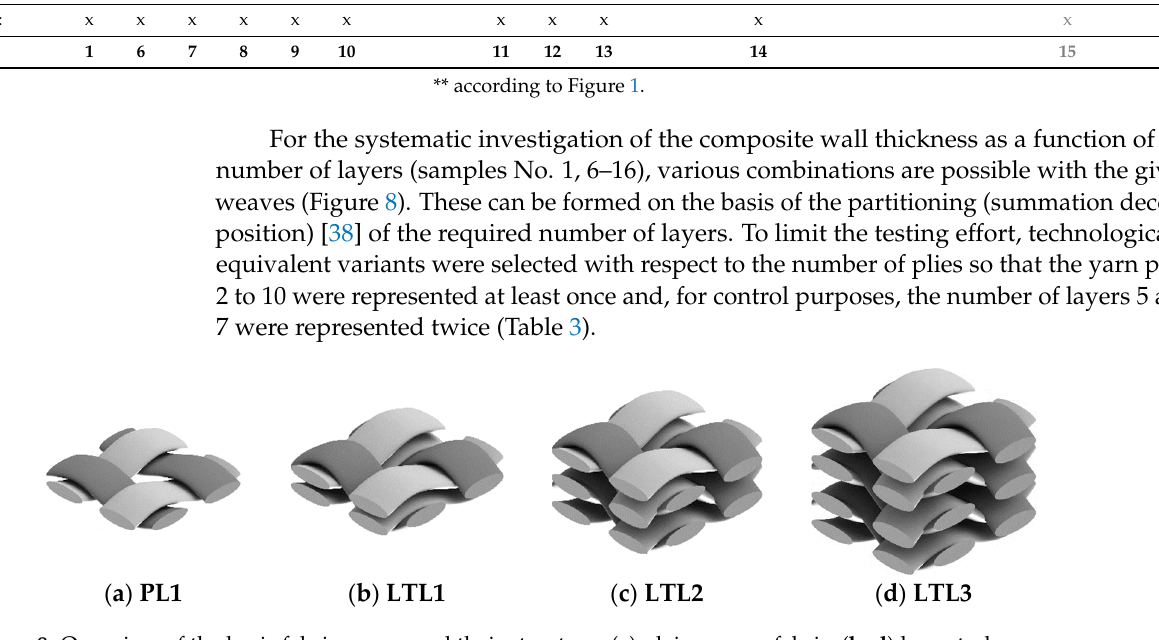
Figure 10. Temperature–pressure–time diagram of the sample consolidation. 4.2. Methods All measurements on textile and composite samples were carried out under standard climate conditions (DIN EN ISO 139: 20 °C, 65% rel. humidity) [39] and after a minimum of 48 h sample conditioning, in order to establish an equilibrium with regard to the water absorption of polyamide from the environment. The fabric thickness was measured with a Rainbow digital textile thickness tester from KARL SCHRÖDER (Weinheim, Germany) in combination with a digital measuring de- vice (Sylvac S229, SYLVAC, Yverdon, Schwitzerland, Figure 11) according to DIN EN ISO 139 [40] (measuring plunger pressure area 25 cm 2 , test pressure 2 kPa). The measurements were made 30 s after specimen gripping. Eight measured values were distributed over the specimen areas, and the average material thickness was determined from them. Paper support (measured: thickness 0.3 mm; area density 0.231 kg/m 2 ) was used to transfer the specimens between cutting, measurement, and consolidation, and its values were sub- tracted from the measured values in the evaluation. The consolidated samples were also tested according to the same methodology. Furthermore, the fiber volume content was determined on random samples according to DIN EN ISO 1172 [41]. The areal density was determined gravimetrically on all samples.